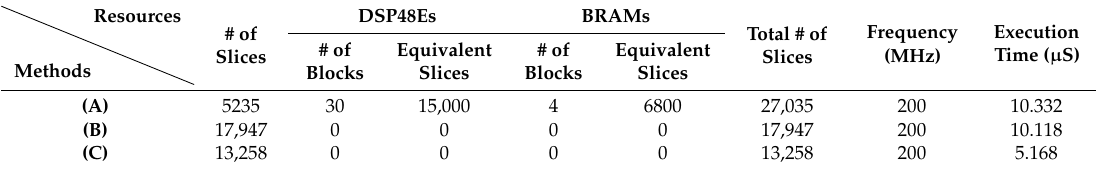
Frequency Total # of Slices